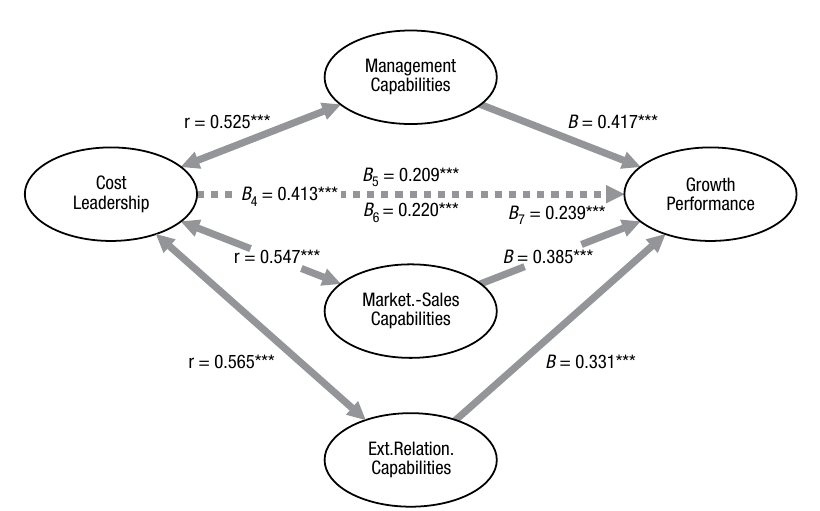
Fig. 2. The mediating effects of management, marketing-sales and external relationship capabilities on the relationship beetwen cost leadership strategy and growth